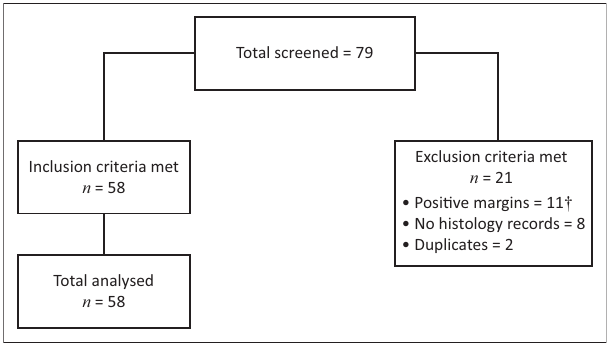
FIGURE 1: Flow diagram of the study population used for this study.